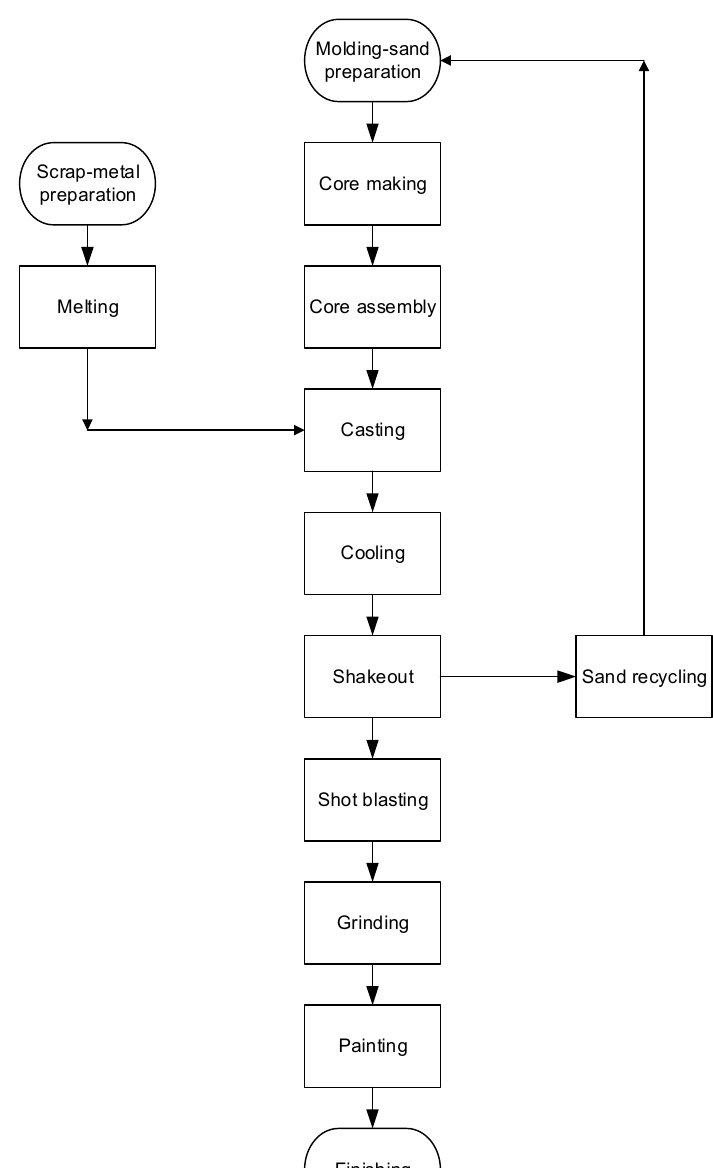
Figure 1. Main manufacturing processes of the foundry industry.